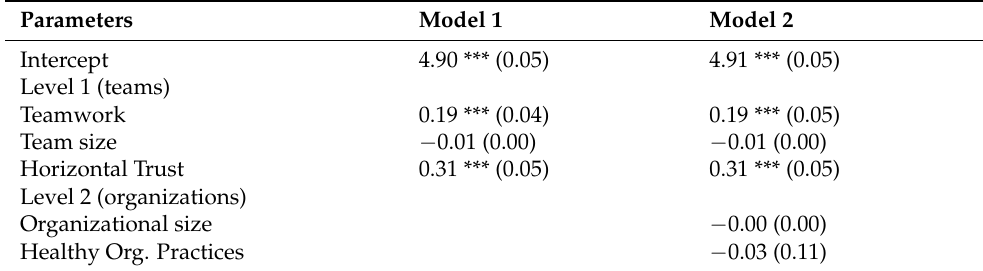
Table 8. Results for the hierarchical linear models predicting performance (ICC = 12%).